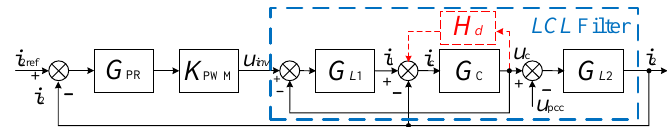
Figure 12. Equivalent control diagram of output current loop with virtual inductance.